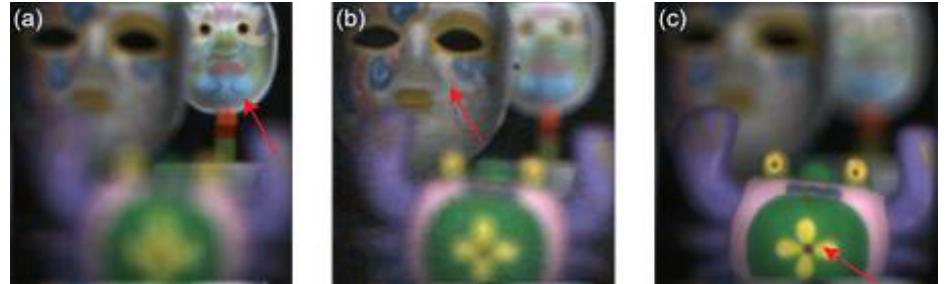
Figure 7. The images digitally refocused at ( a ) the farthest object, ( b ) the middle object, and ( c ) the nearest object indicated by the red arrow respectively (see Visualization 2).